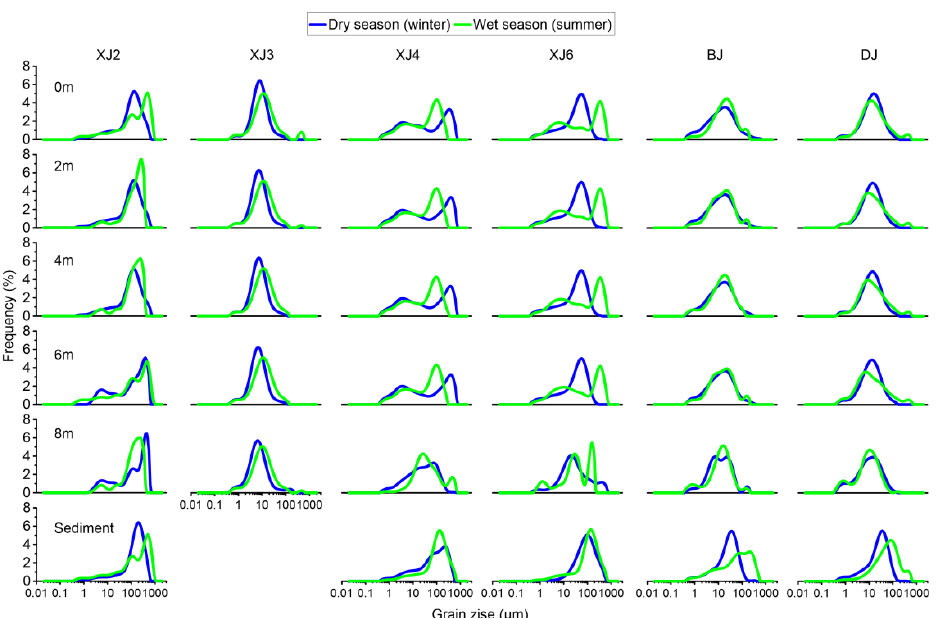
Figure 5. Grain size distribution of suspended particles and surface sediment. Table 4. Seasonal comparison of chemical parameters of water column at various sites in Pearl River.